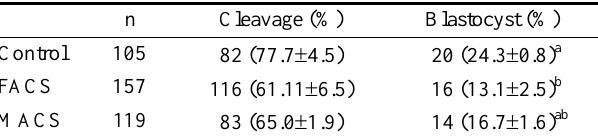
a,b Values with different superscript letters in the same column indicate significant differences.